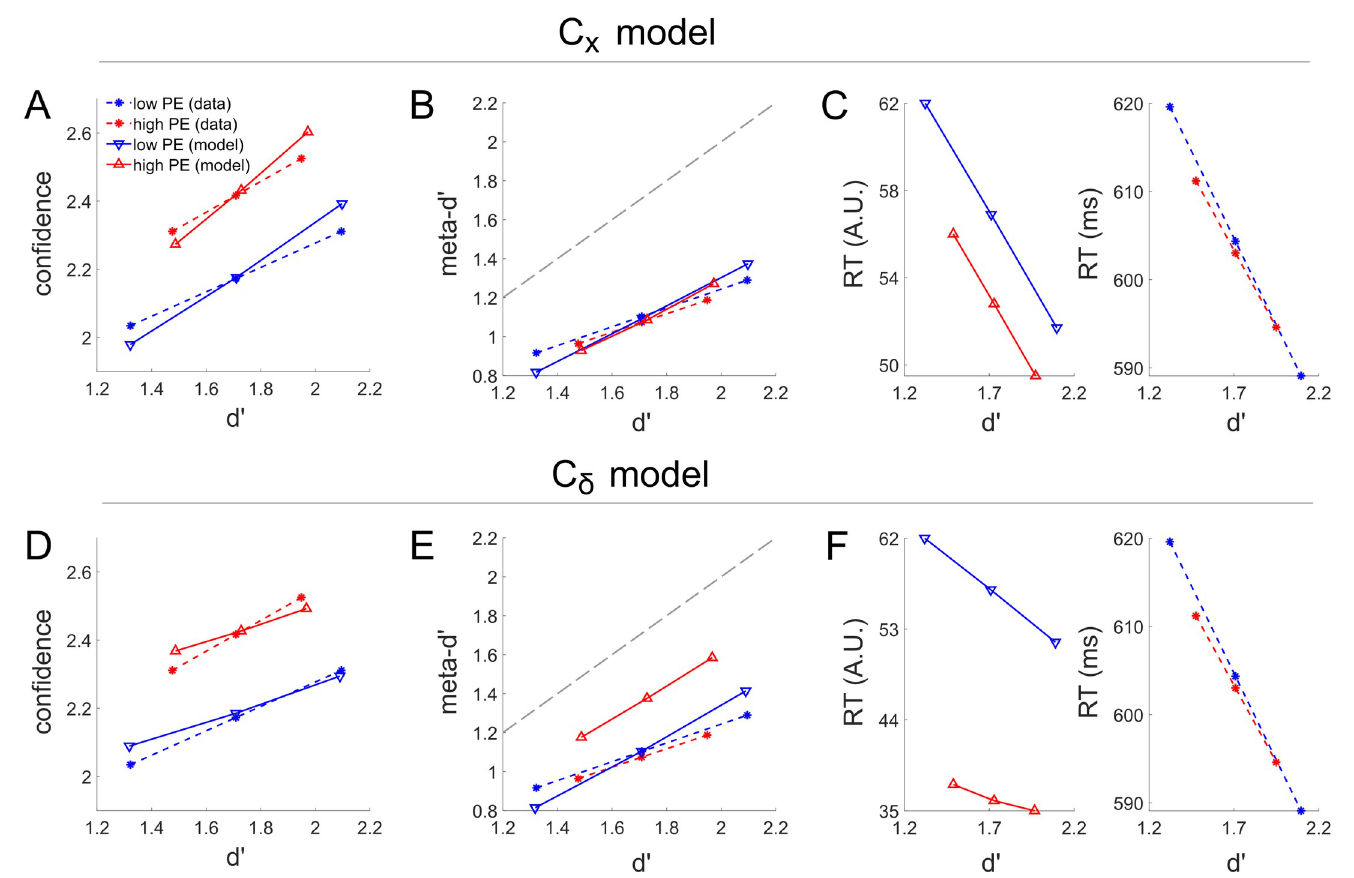
Fig 4. Modeling results for the effects reported by Koizumi and colleagues [10] in their Experiment 1A with α low PE = 0.1 (corresponding to the first row of Fig 3) and parameter values chosen to best capture the effect of PE level on mean confidence (corresponding to the data points shown in black circles in Fig 3). The fitted main C x model reproduces the differential confidence for matched d’ performance for high versus low PE stimuli (A), as well as the overlapping distributions of meta-d’ as a function of d’ (B). The main C x model predicts a small different in reaction time as a function of PE (C) not seen in the empirical data, but the magnitude of the RT difference across PE levels is small relative to the magnitude of the RT difference across difficulty levels (higher d’ leads to much faster RT). In contrast, while the alternative C δ model can reproduce the differential confidence as a function of PE level given matched d’ (D), it fails to capture the overlapping relationship between d’ and meta-d’ (E) and predicts overly large RT differences as a function of PE relative to the impact of d’ on RT (F). Thus, the main C x model overall produces much closer fit to the data. Note that in the empirical data, there were only two levels of task difficulty; these correspond to the first and last data point in each linear curve in this plot. The second data point in each curve corresponds to the mean d’ across difficulty levels in the Low PE condition, which was used for model fitting purposes (see Methods for